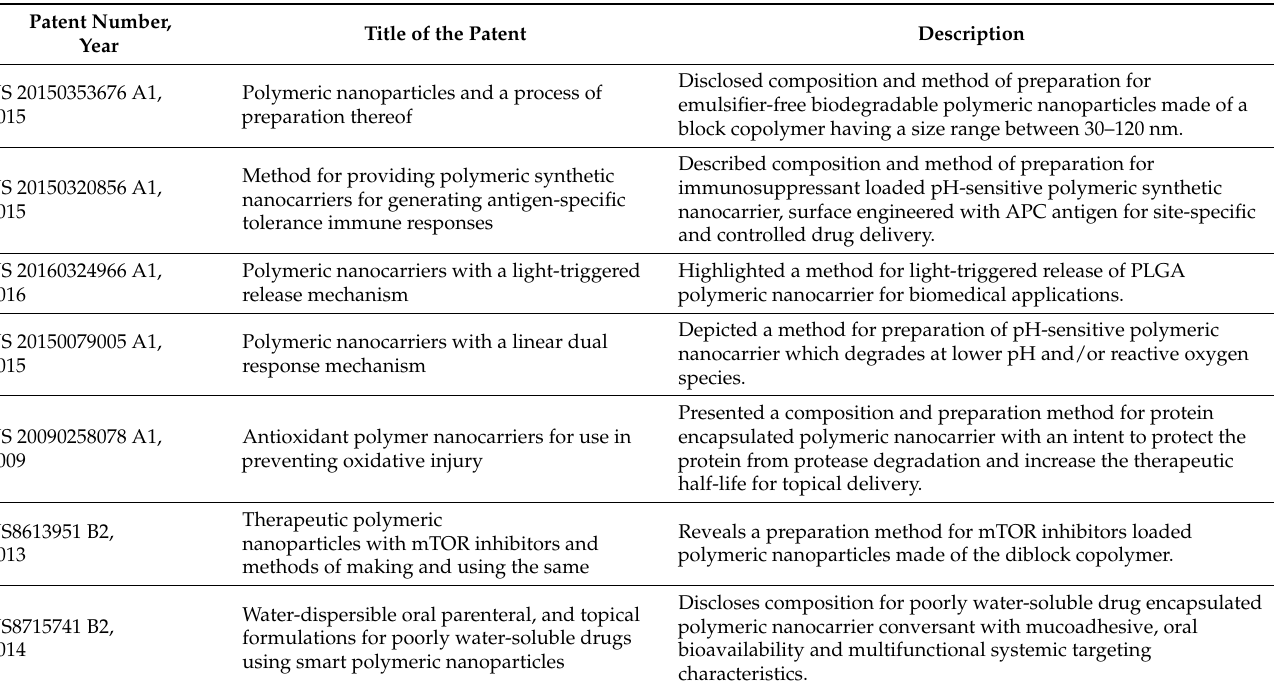
Table 8. A random sample of patent reports on polymeric nanocarriers intended for oral, ocular, topical, and parenteral